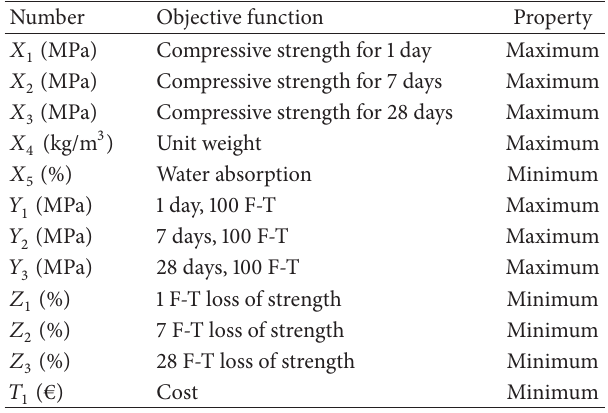
Table 5: Mortar mixture properties. Table 6: Functions used in optimization and their